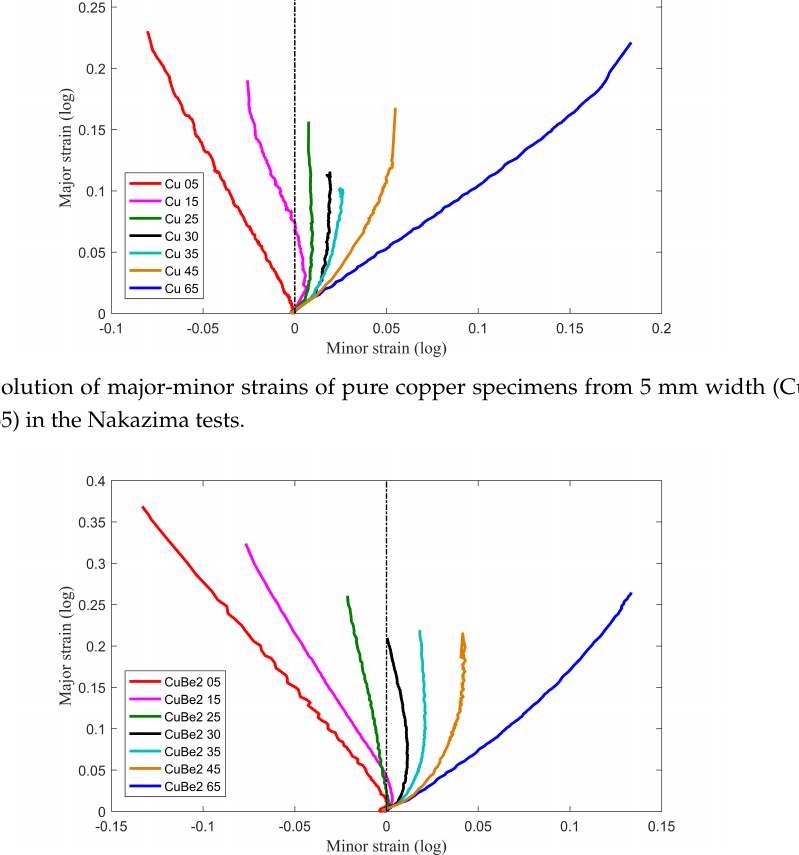
Figure 6. Evolution of major-minor strains of CuBe2 alloy specimens from 5 mm width (CuBe2 05) to 65 mm (CuBe2 65) in the Nakazima